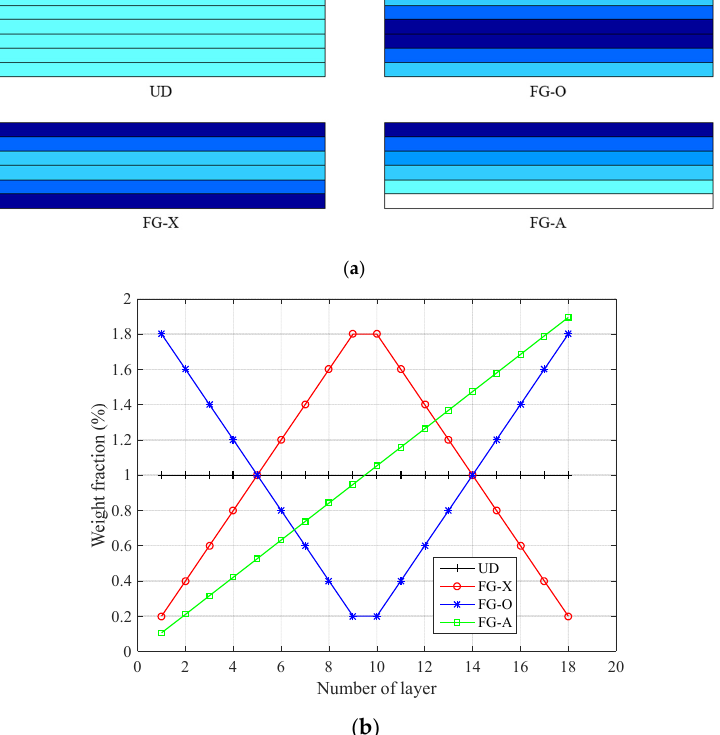
Figure 2. A view of ( a ) the GNPs distribution patterns considering ( b ) its weight fraction variation versus the number of layers.